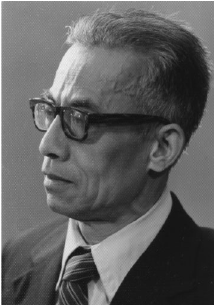
Figure 4. Si-Ho Tchou in the early to the Hang- zhou